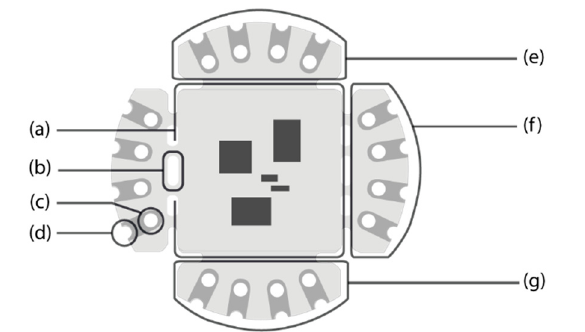
Figure 1. ( a ) Core with components; ( b ) fixing holes; ( c ) full via; ( d ) half-hole via; ( e , g ) contact pads for additional signals; ( f ) outer contact pads for communication bus.